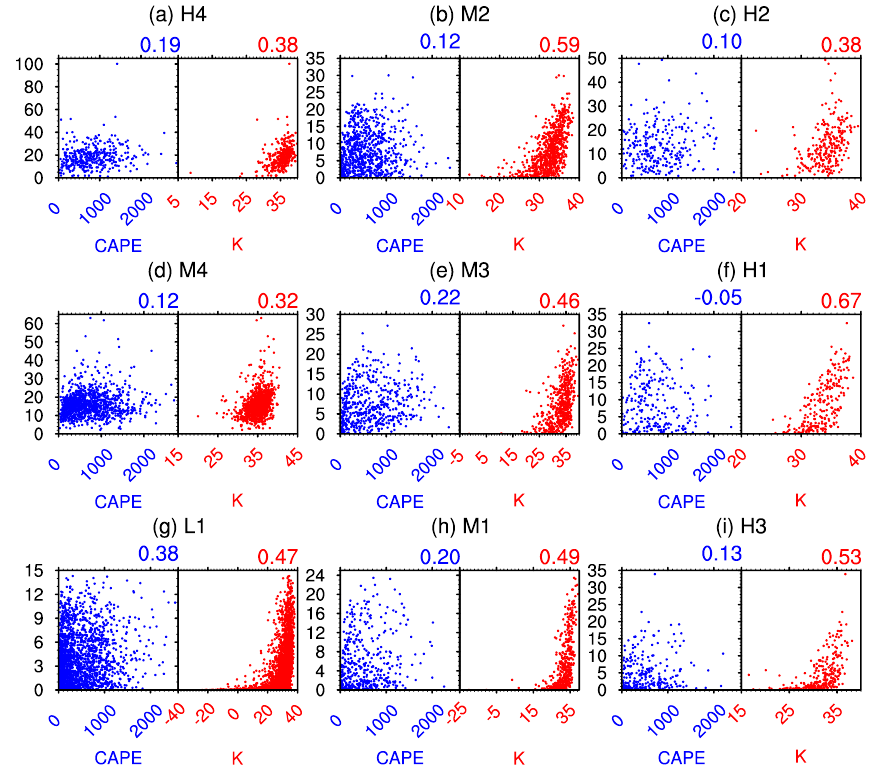
Figure 12. ( a – i ) Relationships between regional average precipitation (units: mmday − 1 ) and CAPE (units: Jkg − 1 ) and K index over Guangdong Province (21.5–25 ◦ N, 109–117 ◦ E) under the nine regimes. The left part of each panel denotes the relationships between regional average precipitation and CAPE, and the right part of each panel denotes the relationships between regional average precipitation and K index. The correlation coefficients between regional average precipitation and CAPE are given at the top right of left part of each panel, while the correlation coefficients between regional average precipitation and K index are given at the top right of right part of each